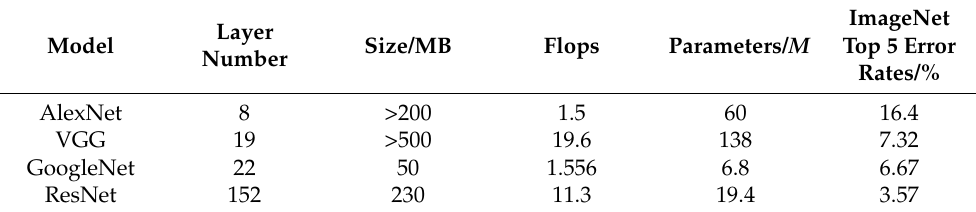
Table 1. Comparison of classical CNN models on